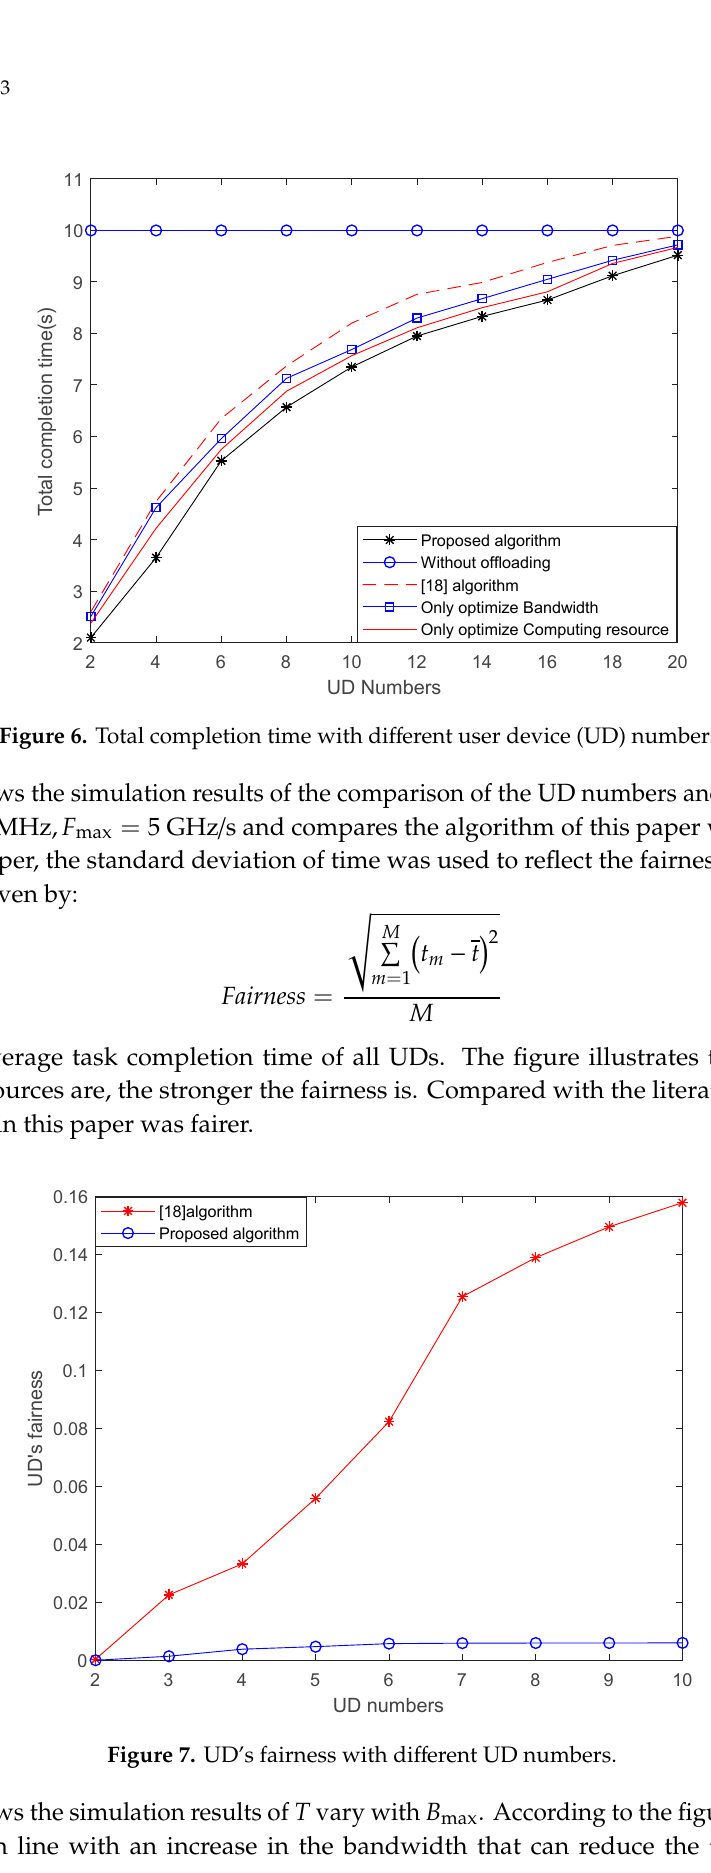
Figure 7. UD’s fairness with different UD numbers.